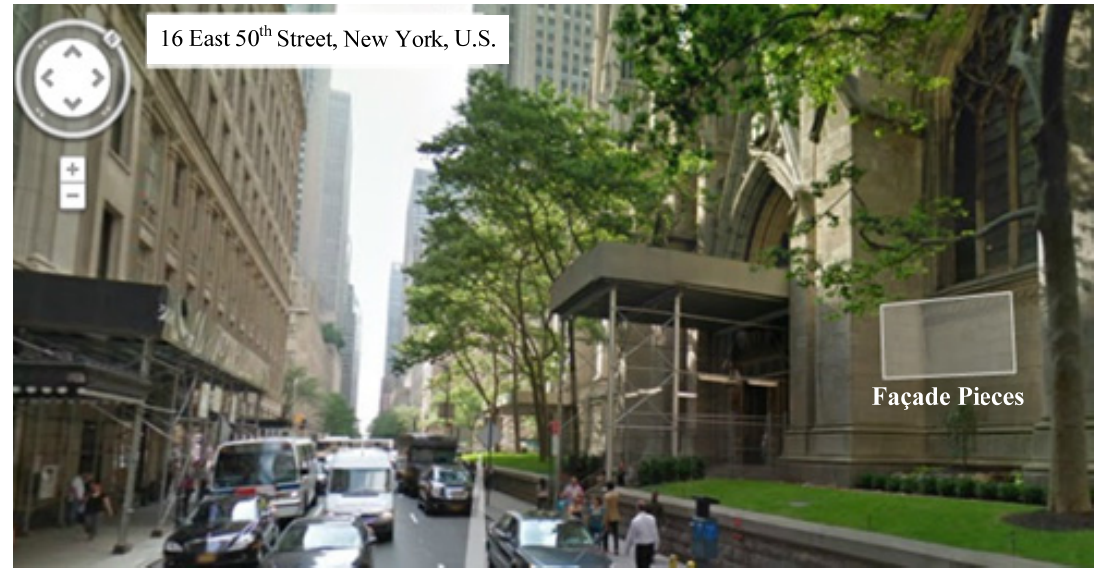
Figure 1. Google Street View (GSV) with building facade pieces.